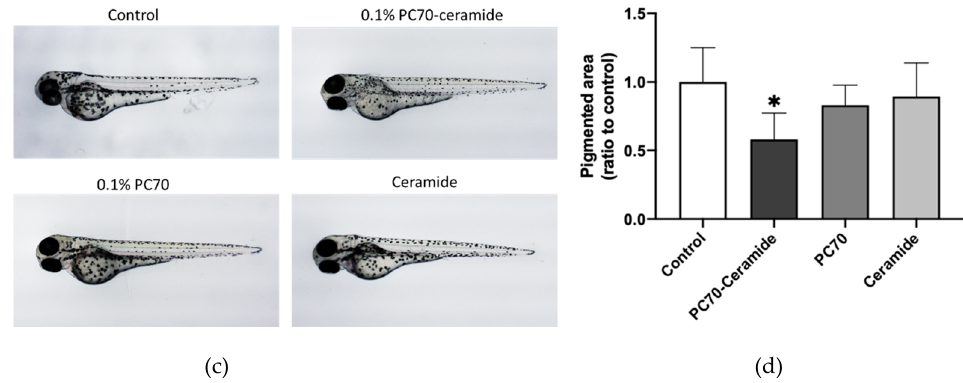
Figure 1. PC70-ceramide suppresses pigmentation in zebrafish. ( a ) Structures of lecithin used in this study and electron microscope image of PC70-ceramide (10,000 × magnification; yellow arrows). ( b ) Survival rate for zebrafish larvae treated with lecithin-ceramides. The fish were treated with each compound from 24 h post-fertilization (hpf) for 5 days. * p < 0.05, ** p < 0.01, and *** p < 0.001 vs. control. n = 3, error bars indicate SD. ns indicates no significant difference. For the survival rate for lecithin alone, please see Table 1. ( c ) Representative images of zebrafish larvae treated with 0.1% PC70-ceramide (containing 10 µg/mL ceramide), 0.1% PC70, or 10 µg/mL ceramide. The fish were treated with each compound from 24 hpf for 48 h. ( d ) Quantification of pigmentation in zebrafish larvae treated with PC70-ceramide, PC70, or ceramide. * p < 0.05 vs. control. n = 12, error bars indicate SD. Table 1. LC 50 of lecithin and lecithin-ceramides in zebrafish. Lecithin Alone